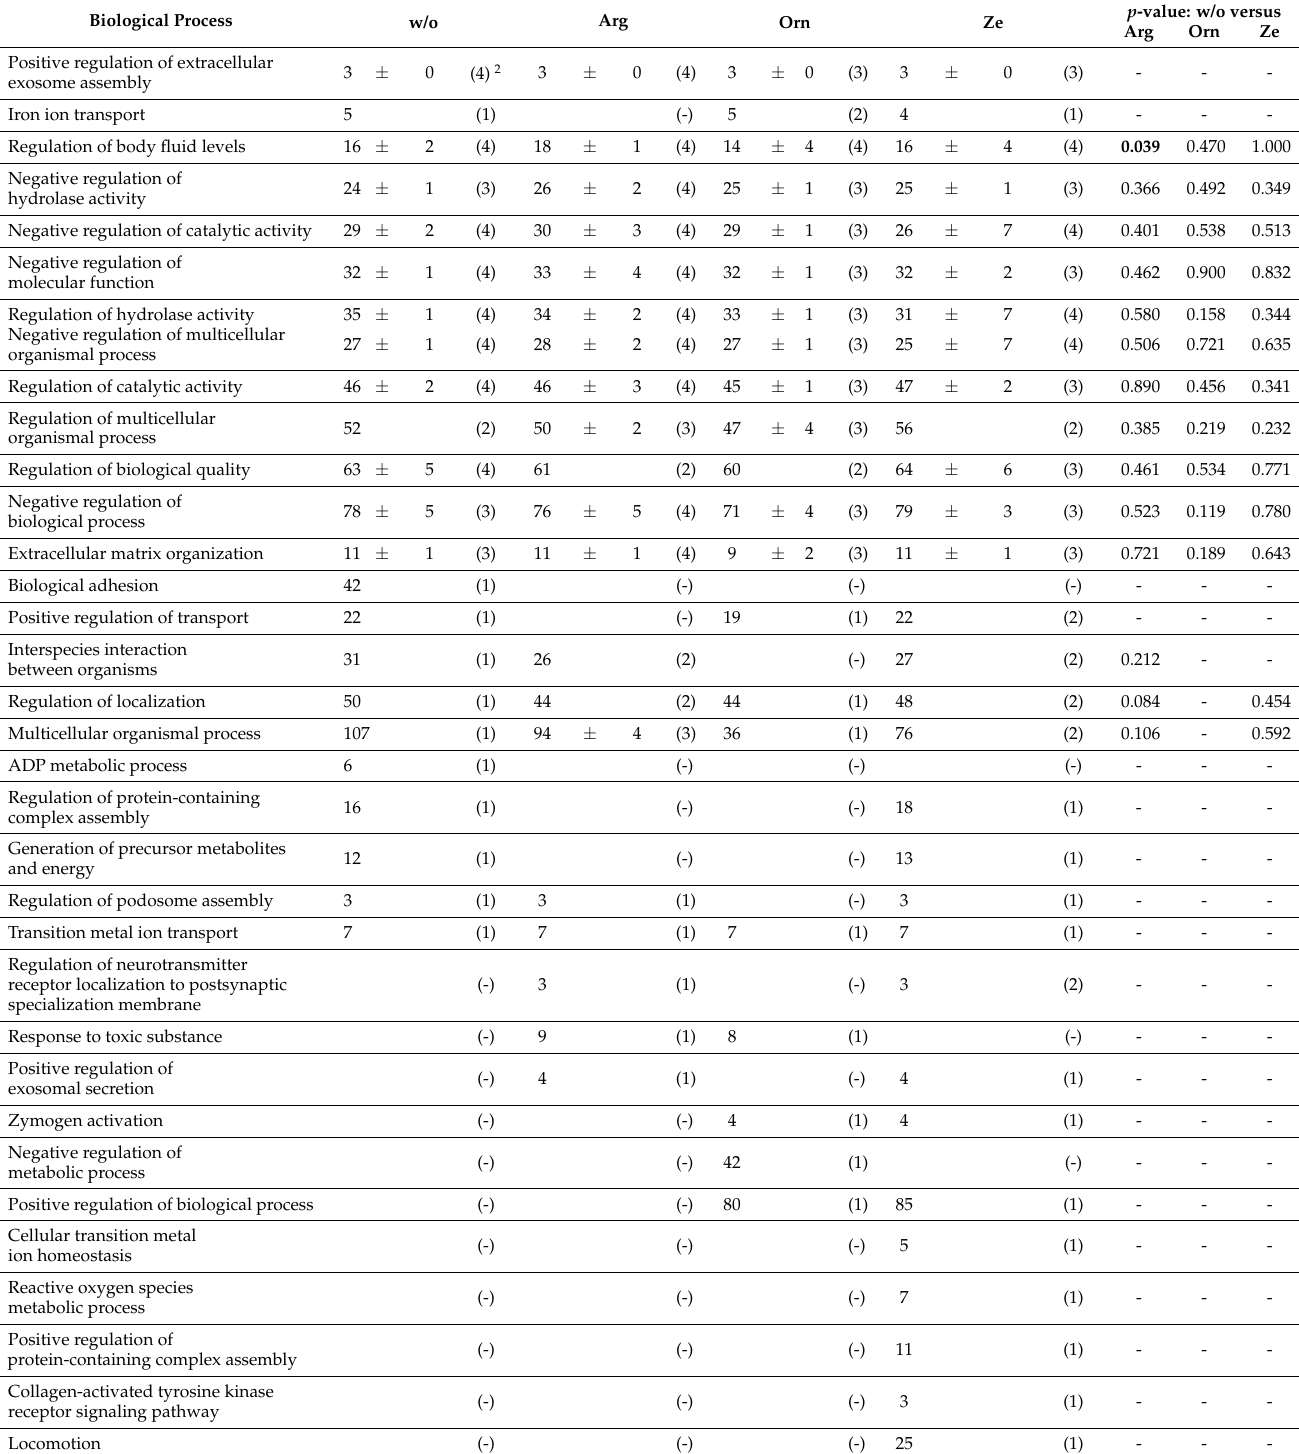
Table 6. Urinary proteins associated with biological processes 1 related to other functional groups, detected in the urine of cats ( n = 4) fed a high-protein diet without (w/o) or with the supplementation of arginine (Arg), ornithine (Orn) or zeolite (Ze). Mean number of proteins ± standard